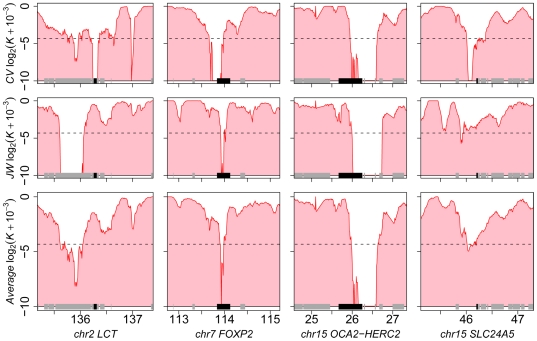
Known selective sweeps identified in individual human
genomes.From left to right, each graph presents the variation of
K at four known examples of selective sweeps in the
European human population, namely the lactase gene LCT,
FOXP2, OCA2-HERC2 and
SLC24A5. The upper, middle and lower panels show
genome scans (200 kb windows in steps of 10 kb) for CV, JW and the
average between both individuals, respectively. The X axis indicates
chromosome coordinates in megabases, the Y axis indicates the
log2 of K (+0.001 to avoid null
values). Dotted horizontal lines delineate the
K = 0.05 threshold.
Genes are highlighted in grey above the X axis, with the gene known to
be affected by positive selection highlighted in black.